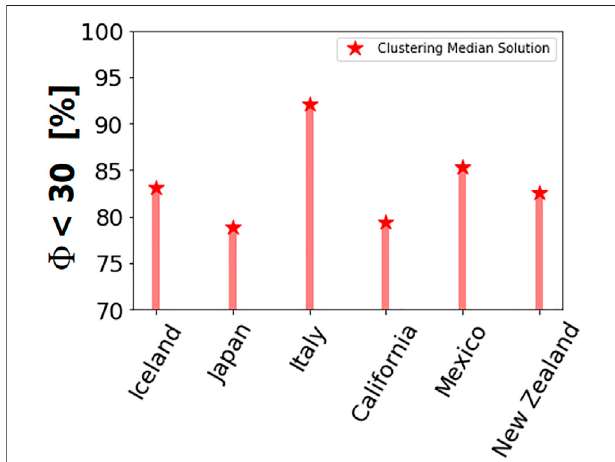
FIGURE7| StatisticalresultsoftheDBSCANalgorithm.Thepercentage considers the subset Ω 3 where the median FM from at least one predicted cluster has Φ < 30 °